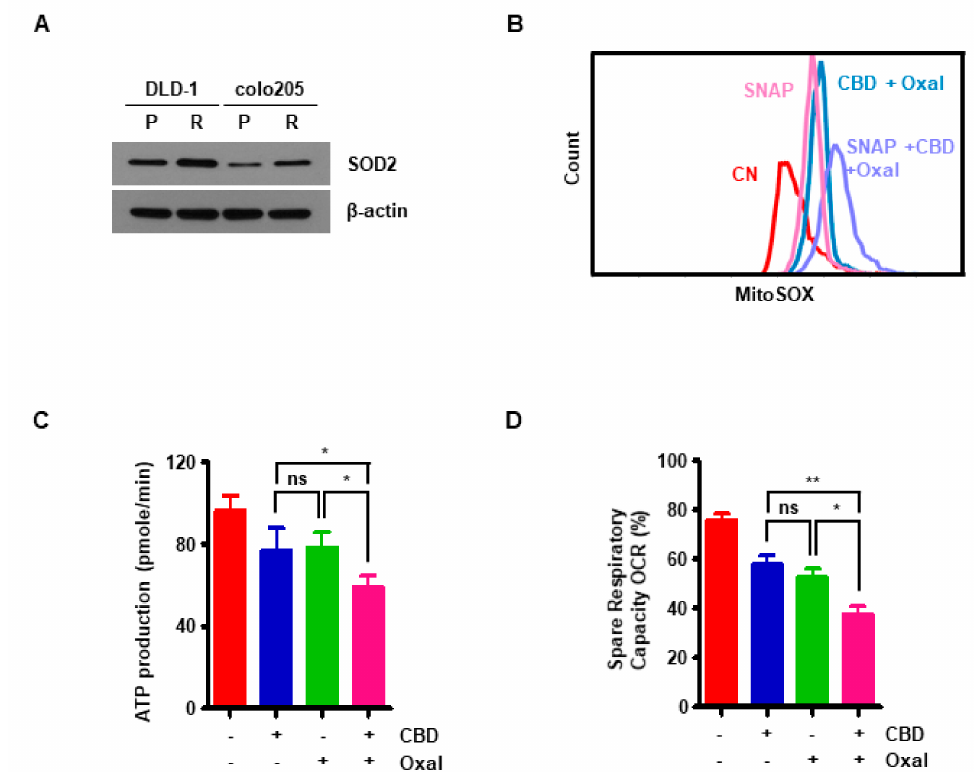
Figure A3. Combined treatment with oxaliplatin and CBD induces mitochondrial dysfunction by SOD2 downregulation. ( A ) The levels of NOS3 and phopho-NOS in parent and oxaliplatin-resistant CRC cells. ( B ) Cells were pretreated with 100 µ M SNAP for 1 h and then treated with oxaliplatin and CBD for 24 h. Cells were then stained with MitoSOX and analyzed by flow cytometry. ( C , D ) colo205 R cells were treated with oxaliplatin and CBD. ( C ) ATP production and ( D ) spare respiratory capacity OCR were quantified. * p < 0.05 and ** p <